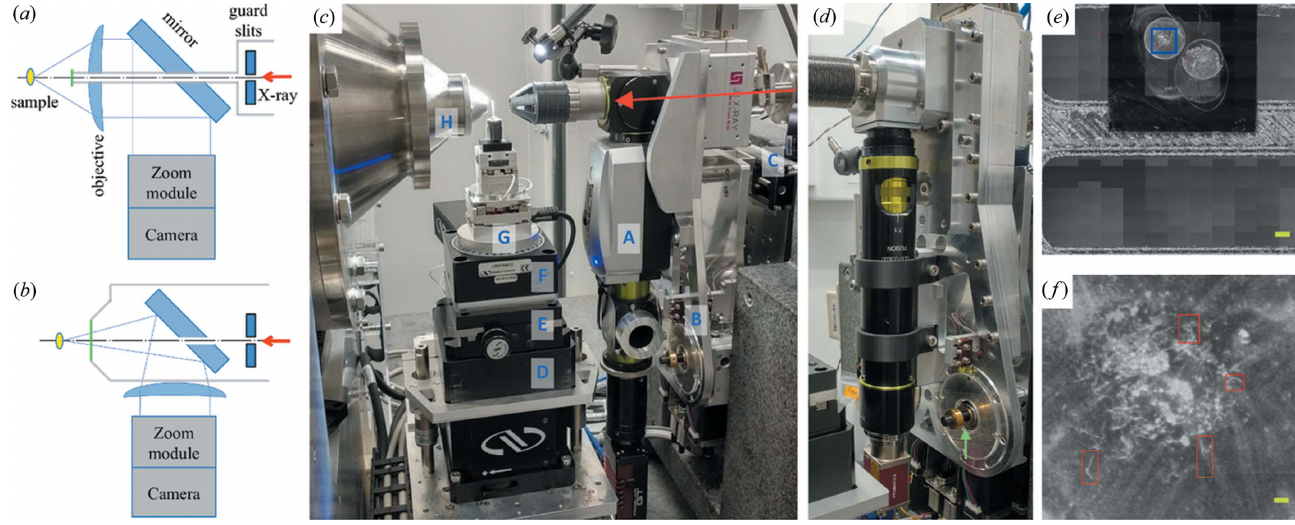
Figure 2 Sample positioning stages and on-axis cameras used for scanning measurements. ( a ) and ( b ) depict the layout of the components in the on-axis viewers shown in ( c ) and ( d ), respectively. The red arrows represent the incident beam. The blue lines show the path of visible light. The gray lines represent the vacuum enclosure and the green line near the sample represents the mica window. The components for the scanning stack are show in ( c ): (A) on-axis viewer, (B) tilt platform, (C) stages for viewer translation, (D) vertical scanning stage, (E) horizontal scanning stage, (D) rotary stage for tomographic data collection, (E) motorized goniometer head and (H) WAXS nose cone. One of the screws for the tilt platform is indicated by the green arrow in ( d ). ( e ) Tiled, full-field sample view assembled from individual on-axis images such as the one shown in ( f ), which corresponds to the blue box in ( e ). The scale bars are 1 mm and 0.1 mm for ( e ) and ( f ), respectively. The user-defined ROIs are shown as red boxes in ( f